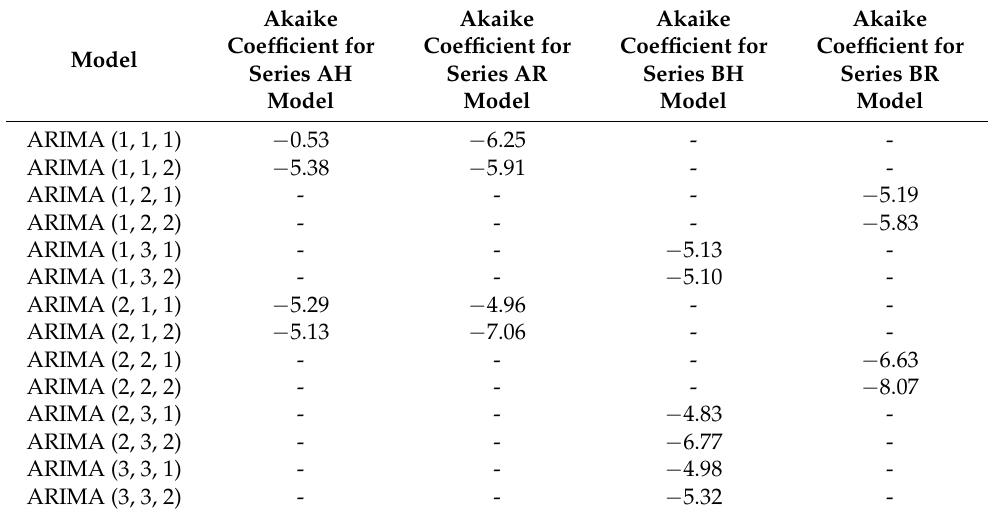
Table 4. The Akaike coefficient for the tested ARIMA models, based on basil heigh time series data.